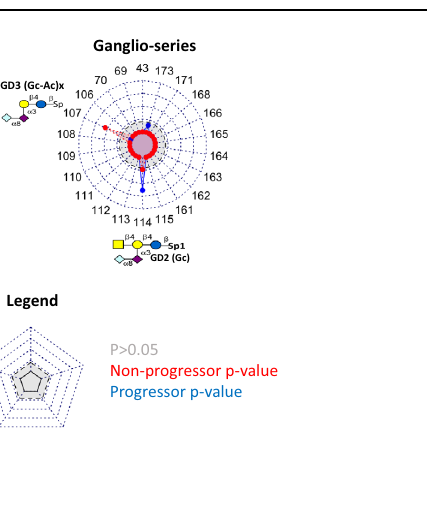
Fig. 2 | ACA communityclusters are enrichedfor functionalglycanclasses and associated with type 1 diabetes phenotypes. a Bubble chart showing glycan classesenriched(lighterblueandlargerbubblesize)ineachACAclustercalculated using fi sher ’ s exact test. b Forest plot showing linear model for the fi rst principal component of each glycan cluster against the clinical variables age at blood draw, presence of fi rst degree relative with T1D, non-progression to T1D, progression to